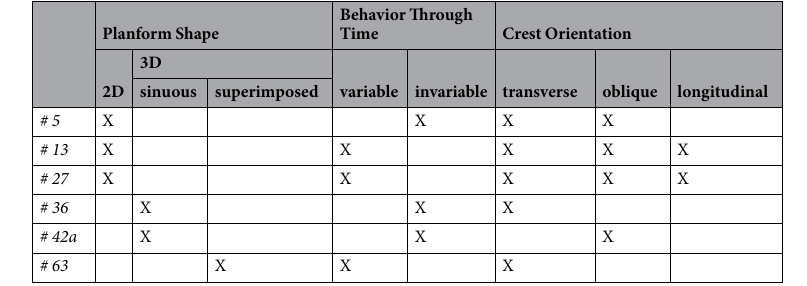
Table 1. Bedform classification criteria used in Rubin and Carter 26 for the six BAMs presented in Fig.